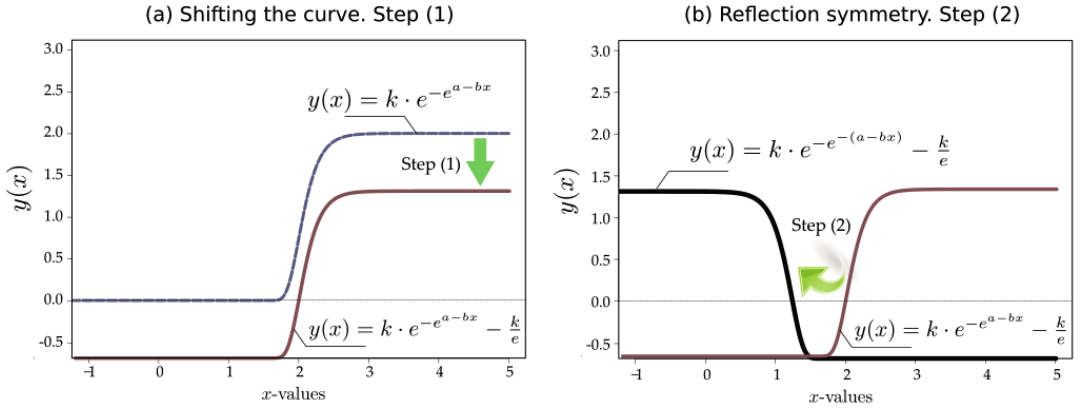
Figure 1. Symmetrized Shifted Gompertz function. Graphical deduction. Shifting the initial curve ( a ) and application of reflection symmetry ( b